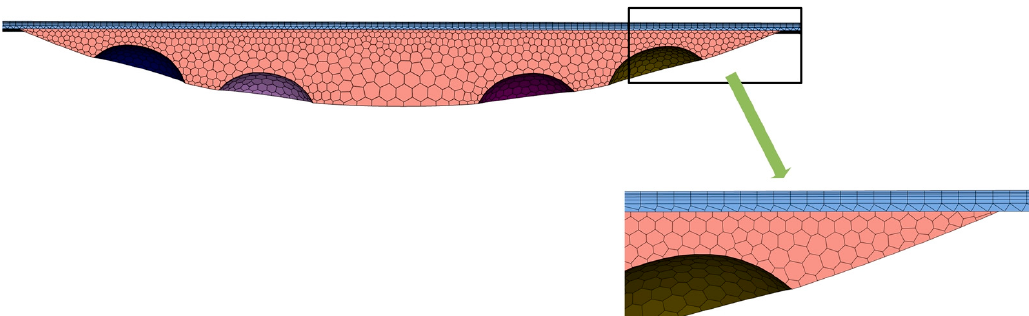
Figure 3. Grid meshing.